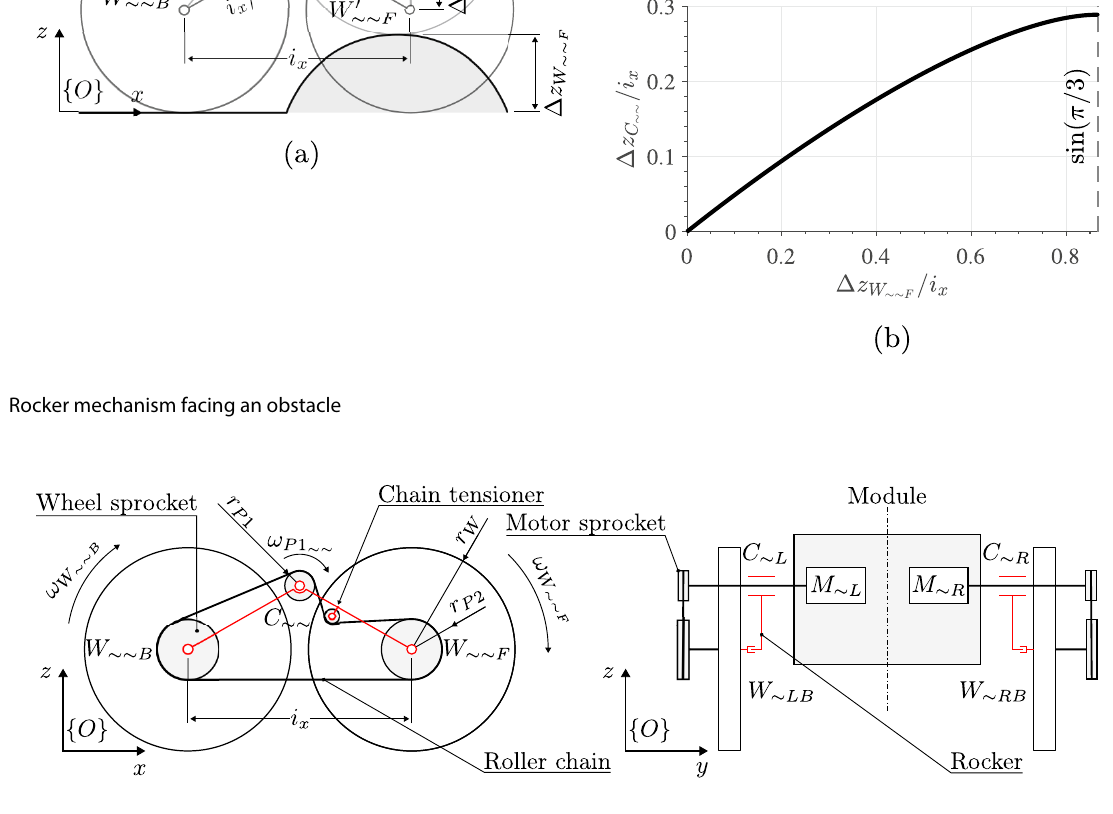
Fig. 6 Locomotion unit chain drive functional